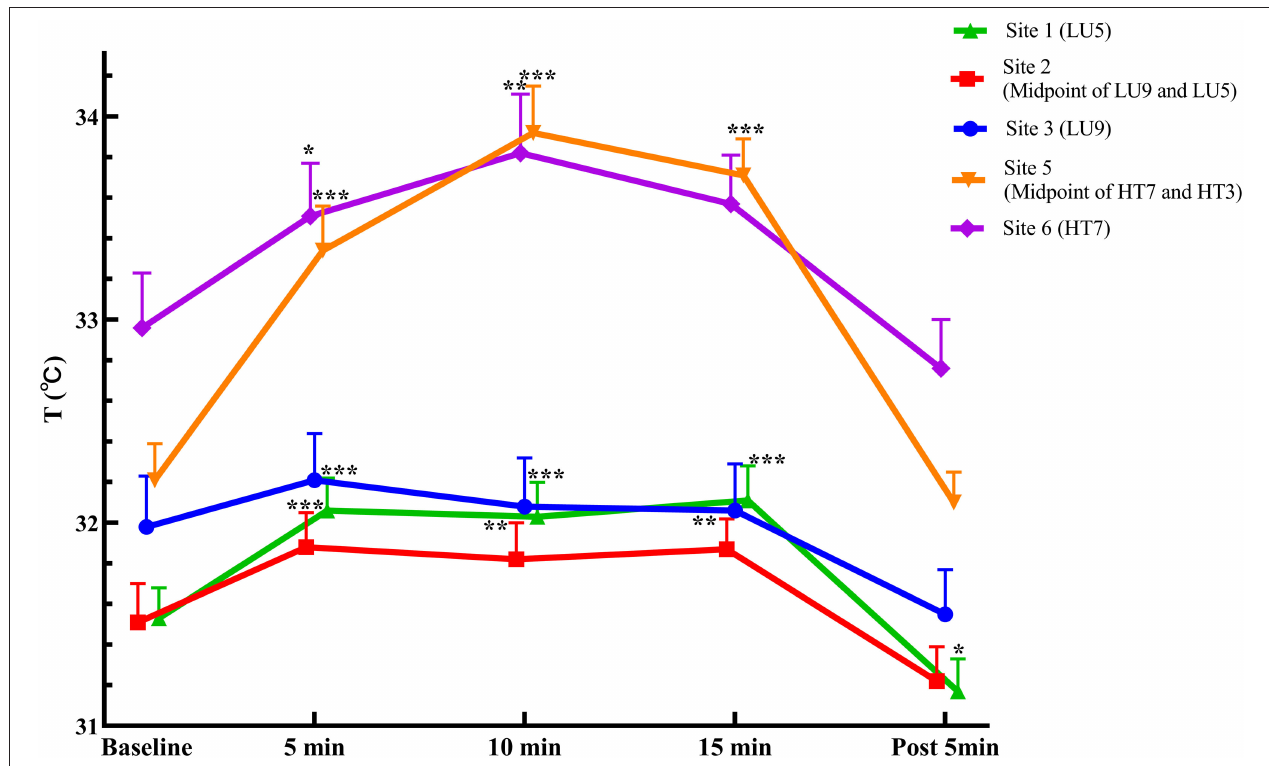
FIGURE 5 | Temperature curves in measurement sites of both meridians in the Heart intervention group (mean ± SEM, ◦ C). *** P < 0.001, ** P < 0.01, and * P < 0.05, compared with